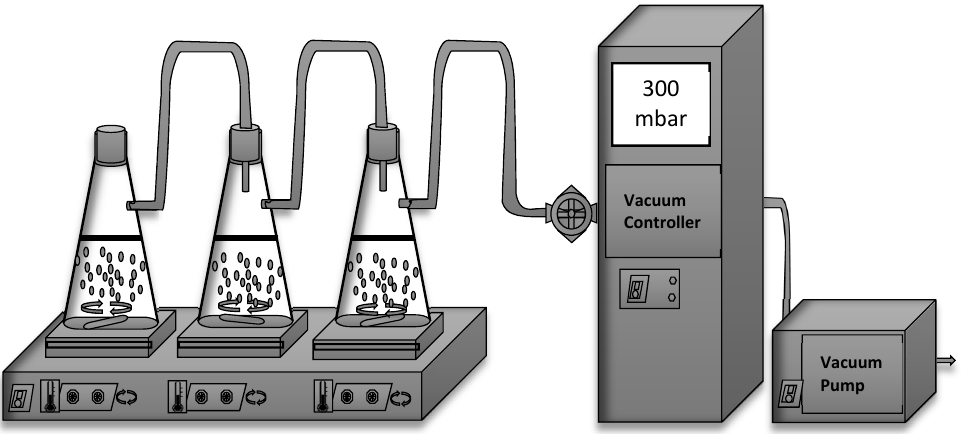
Figure 1. Schematic illustration of the osmotic dehydration process.